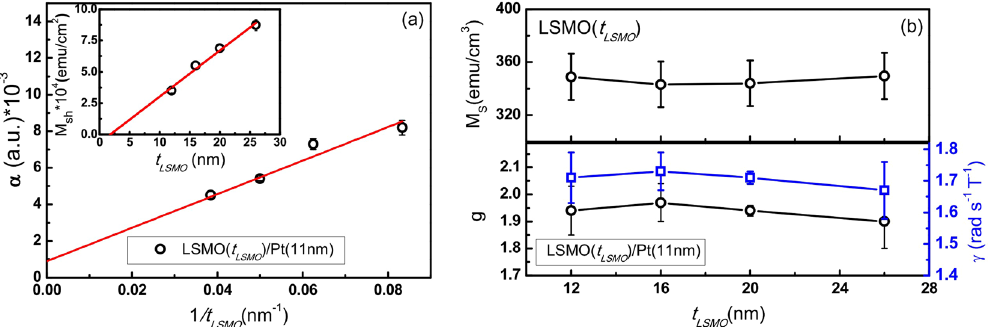
Figure 5. ( a ) The plot of damping constant vs. 1/ t LSMO for LSMO( t LSMO = 12, 16, 20 and 26 nm)/Pt(11 nm) bilayers. The red line represents the linear fit. The inset of ( a ) shows the thickness dependence of the sheet saturation magnetization (M Sh ). The intersection of linear fit yields a magnetic dead layer of 1.7 nm. ( b ) The upper panel shows the bulk saturation magnetization M S for LSMO of different thicknesses. The lower panel shows the fitting results for gyromagnetic ratio ( γ ) and the corresponding